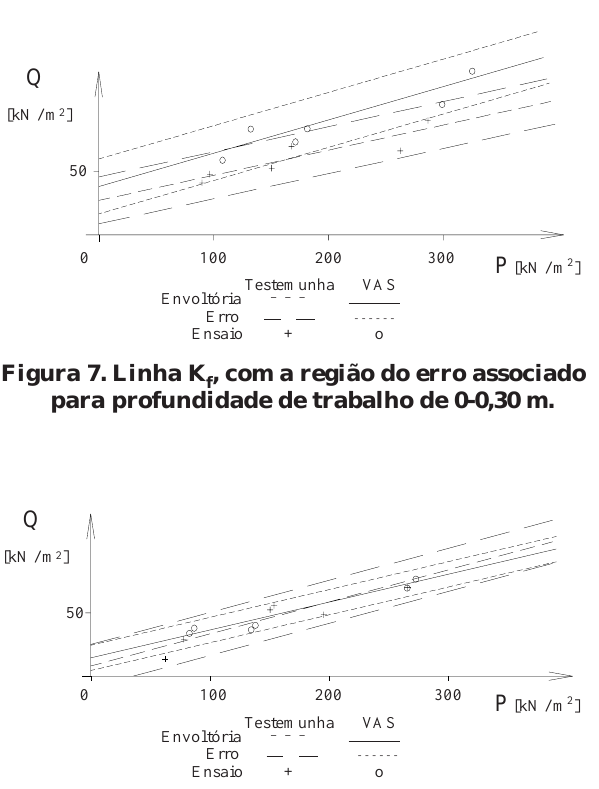
Figura 8. Linha Kf, com a região do erro associado para profundidade de trabalho de 0,30-0,60